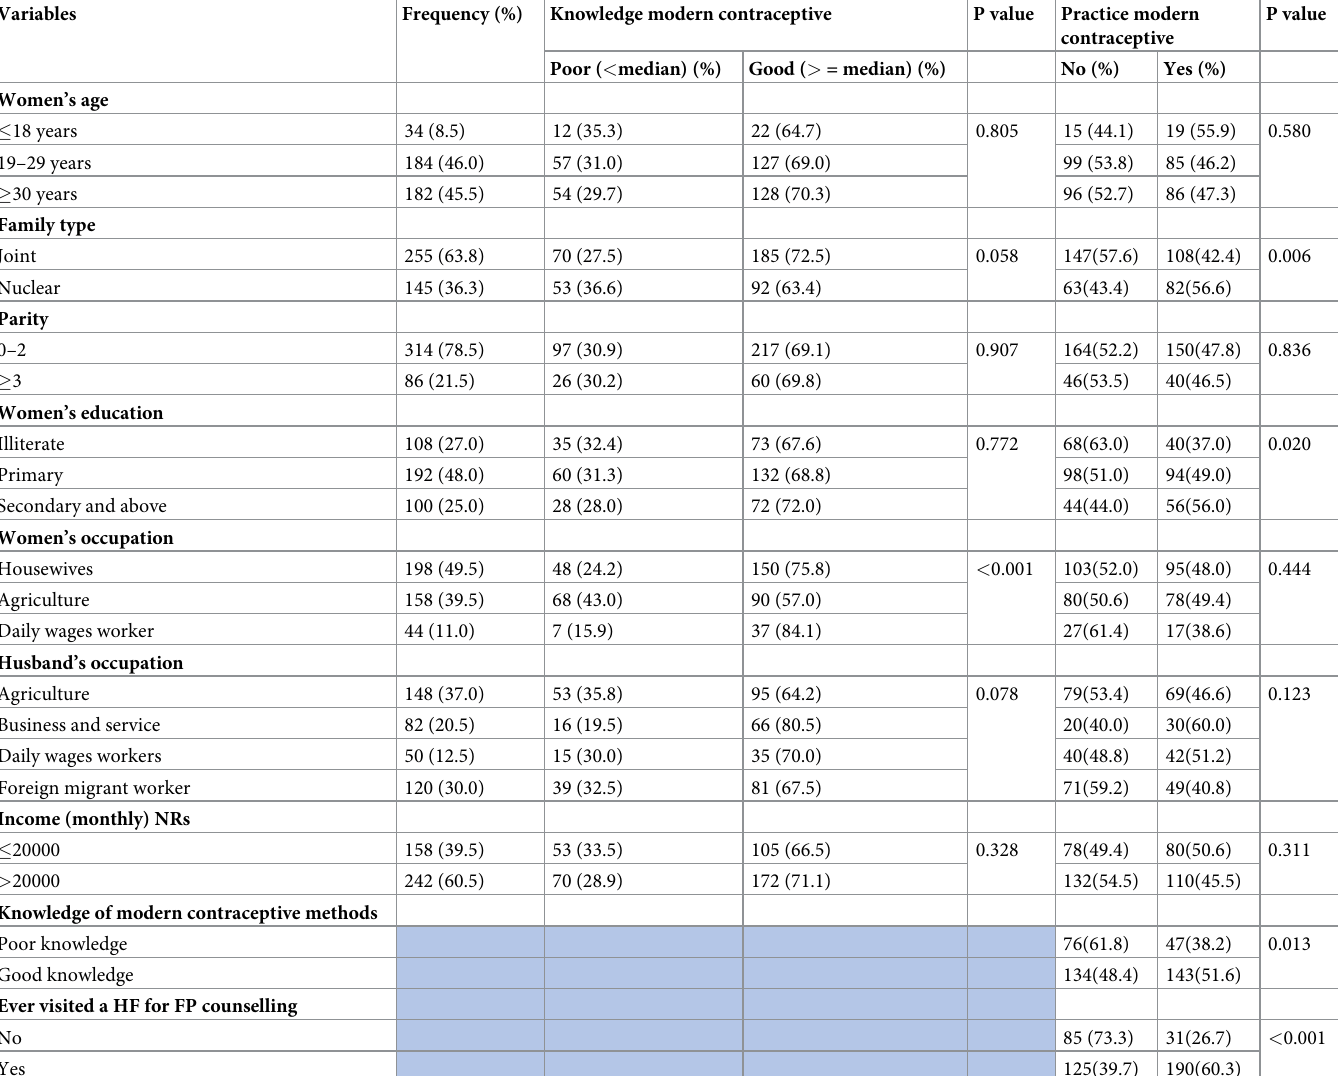
Table 3. Factors associated with knowledge and practices of modern contraceptive methods among Muslim women (N = 400) in